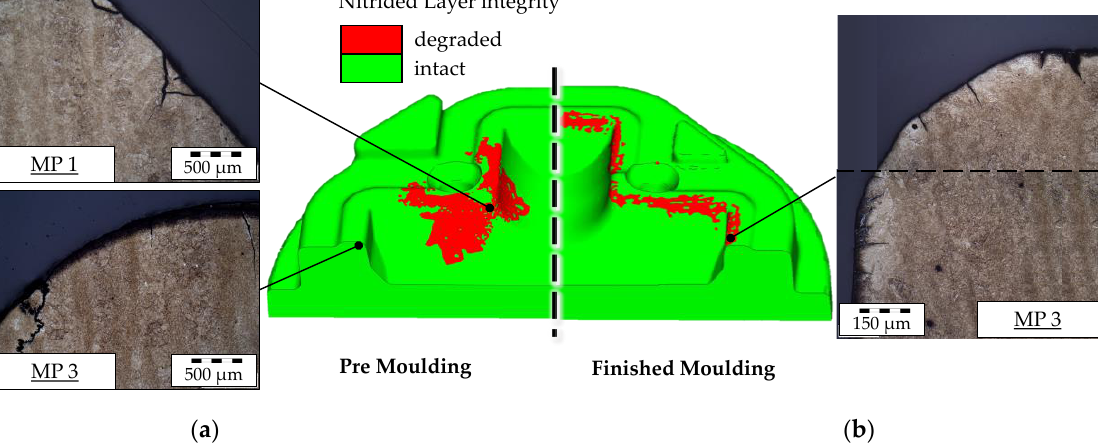
Figure 11. ( a ) Nitrided layer integrity calculation of the premolding and ( b ) finished molding stage compared to microscopic images of the real tool.